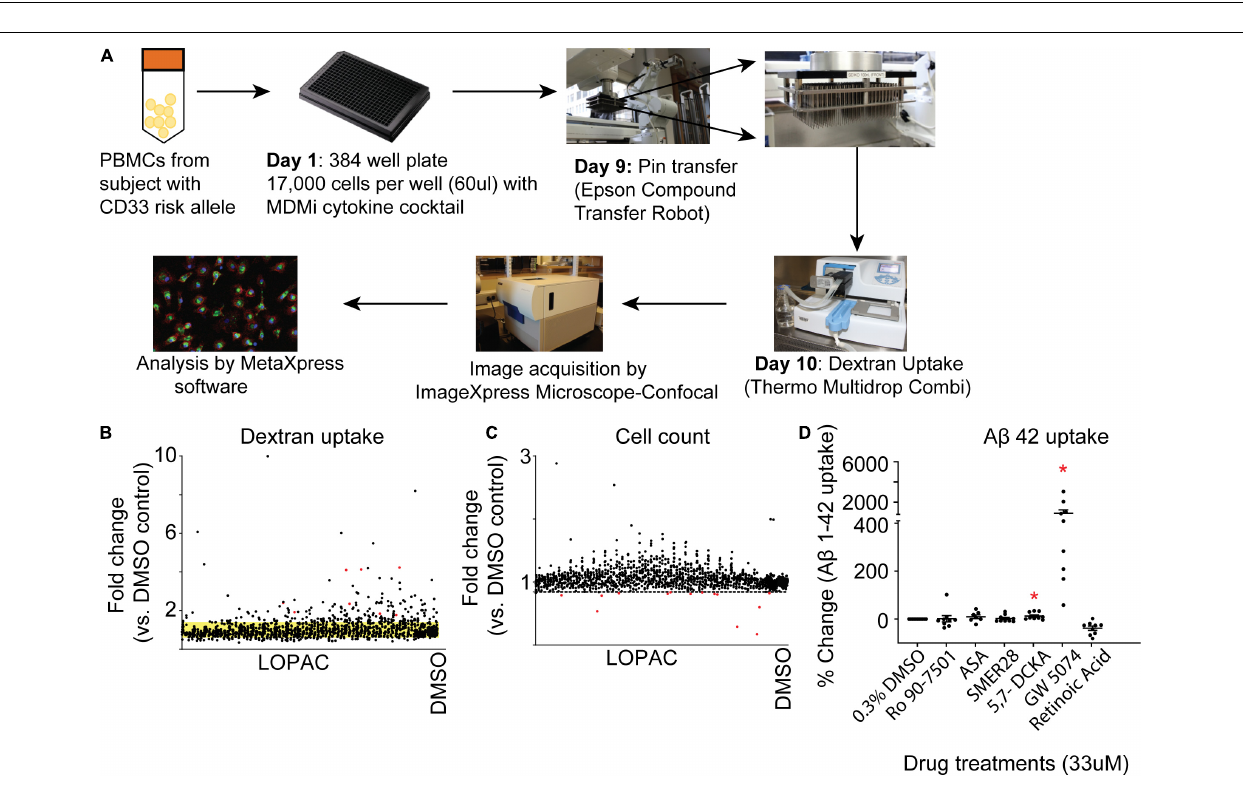
FIGURE 2 | Identification of hit compounds. (A) Schematic of the workflow of the screening process. Monocytes were seeded into a 384 Well Flat Clear Bottom Black Polystyrene Microplate and differentiated to MDMi. On day 9, each well was incubated with a single compound (except for DMSO) for 24 h. The experiment was performed in duplicate. Scatterplot graph is of the first-step screening. (B) Fold change of drug screen compounds compared with the DMSO control were plotted according to the FITC-labeled dextran uptake. The standard deviation of the DMSO control groups is indicated by the yellow band. (C) Fold change of drug screen compounds compared with DMSO control were plotted according to cell count (DAPI). The dotted line indicates three standard deviations below the mean cell count of the negative control. Any drugs below this line are cytotoxic and were excluded from the screen. (D) Hit validation in MDMi with A β 1–42. Monocytes were seeded into a 384 well plate and differentiated to MDMi. Each well was treated with a single hit compound (33 µ M) for 24 h. Cells were incubated with HyLite Fluor conjugated A β 1–42 for 2 h, labeled with CellMask and imaged using the IXM-C. Data expressed as mean percent change compared to DMSO control. Data were analyzed using Student’s t -test. * p < 0.05. Each dot represents individual